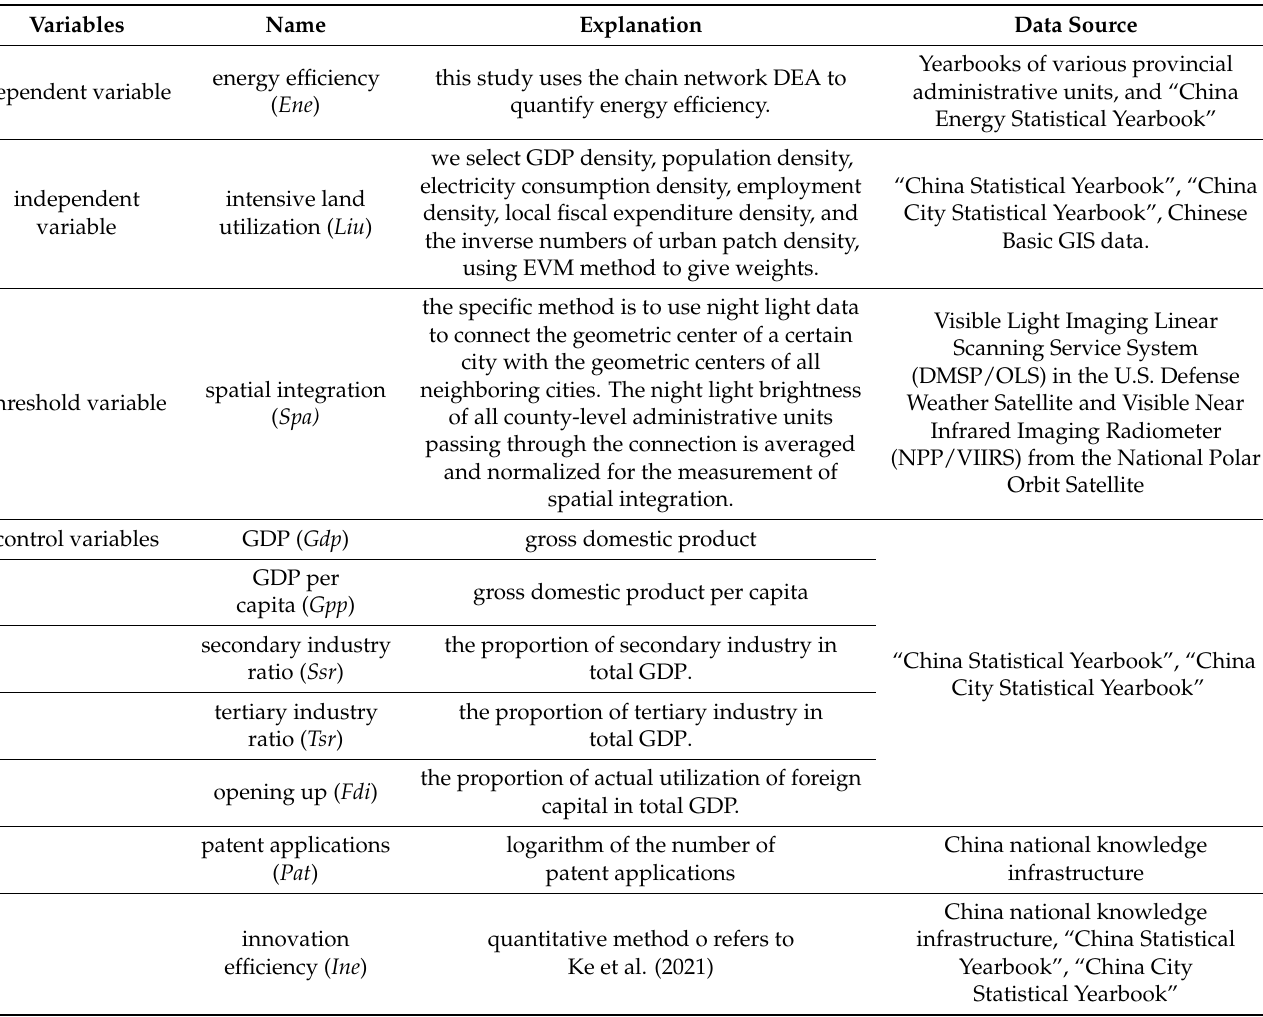
Table 1. Variables